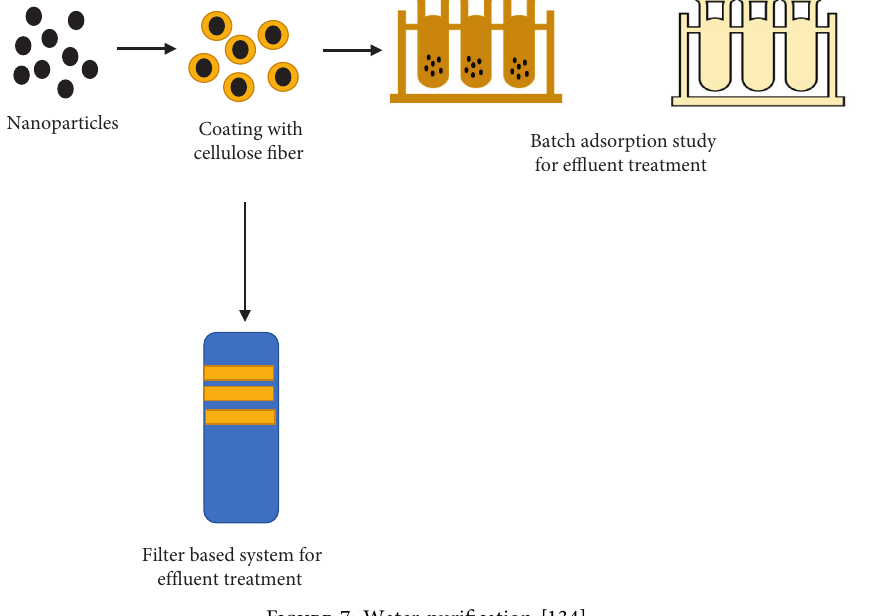
Figure 7: Water purification [134].